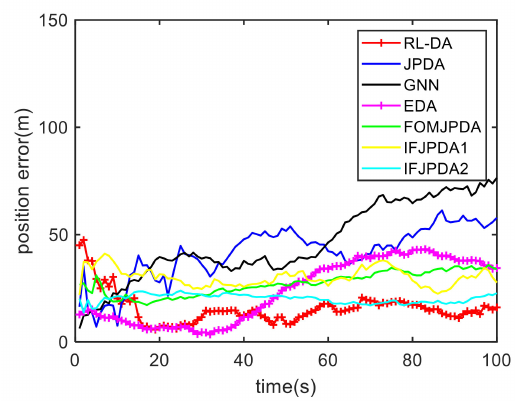
Figure 8. Comparison of the position errors for Target 2 in Case